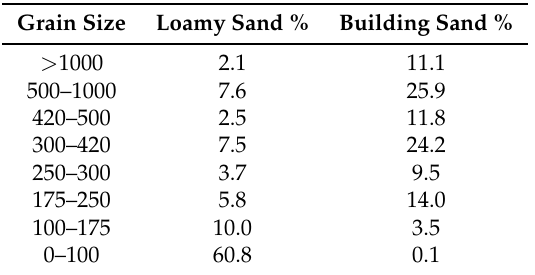
Figure 4. The influence of macropores on drainage for a soil column experiment with building sand, where experiment 3 excludes macropores and experiment 5 includes macropores. Note that the soil column including macropores shows a higher peak and a more narrow breakthrough curve. Table 2. Sieve curves of loamy sand and building sand. Grain Size Loamy Sand % Building Sand